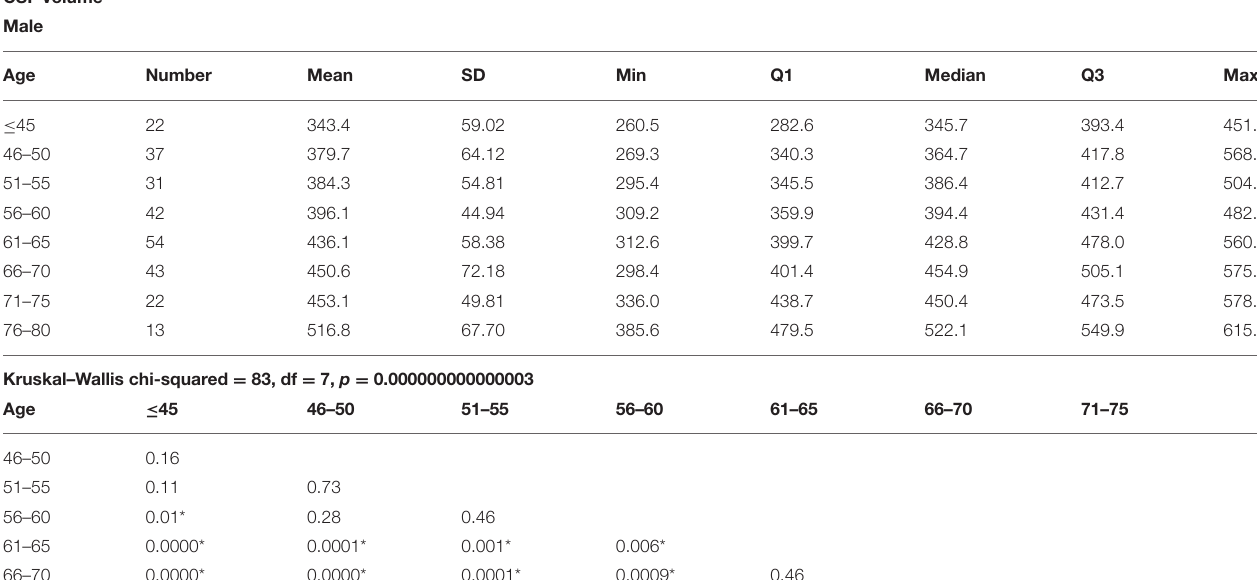
TABLE 4 | The results of total cerebrospinal fluid (CSF) measurements in different age groups and comparisons of the CSF volumes among the age groups separately in men and women. CSF